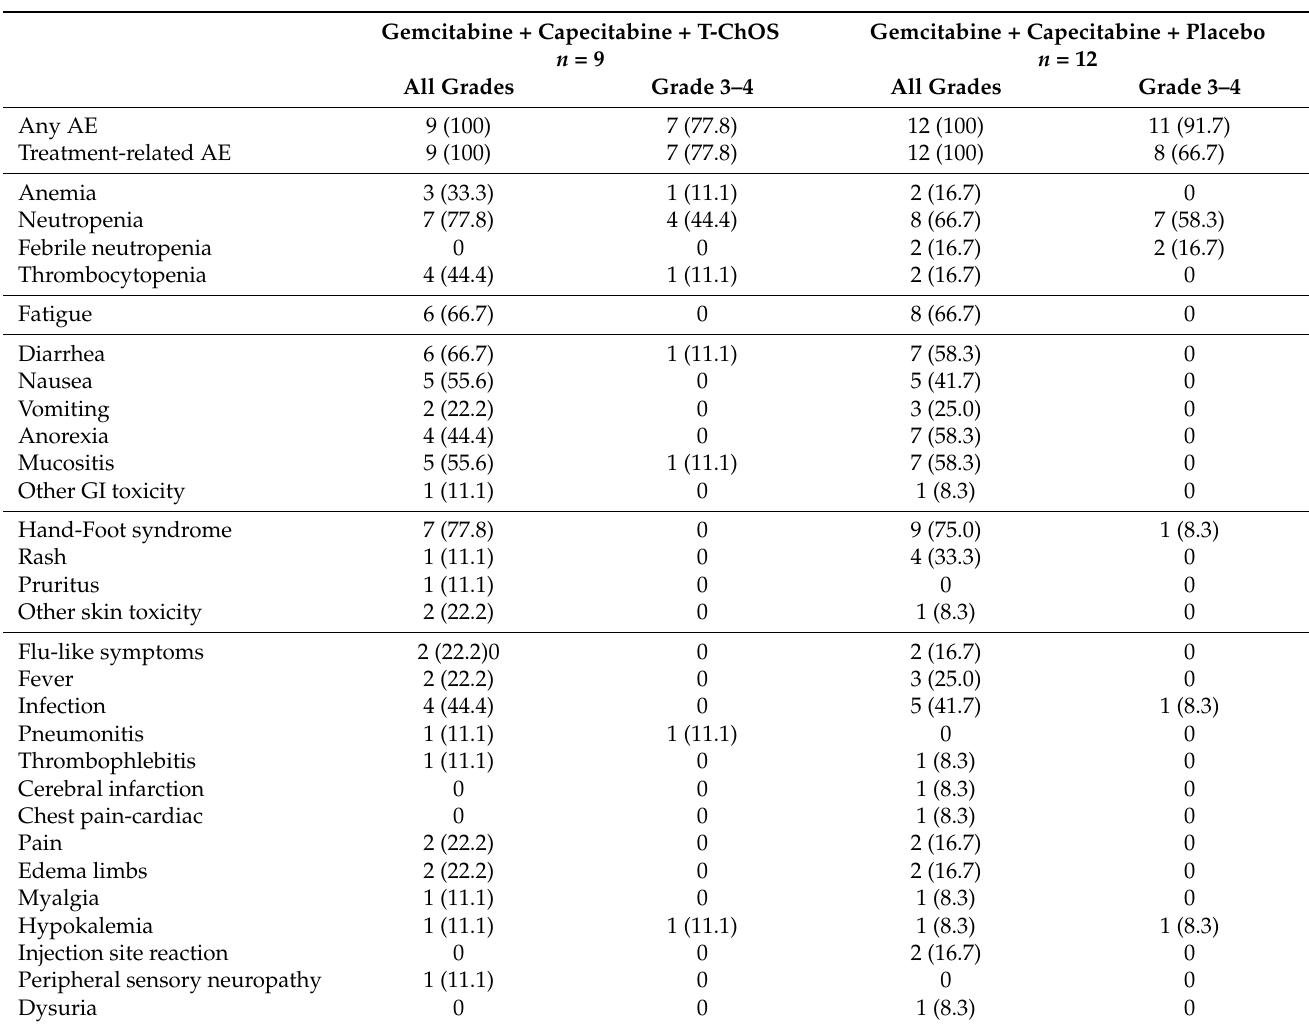
Figure 2. Kaplan–Meier plot for disease-free survival ( a ) and overall survival ( b ). Table 3. Treatment-related adverse